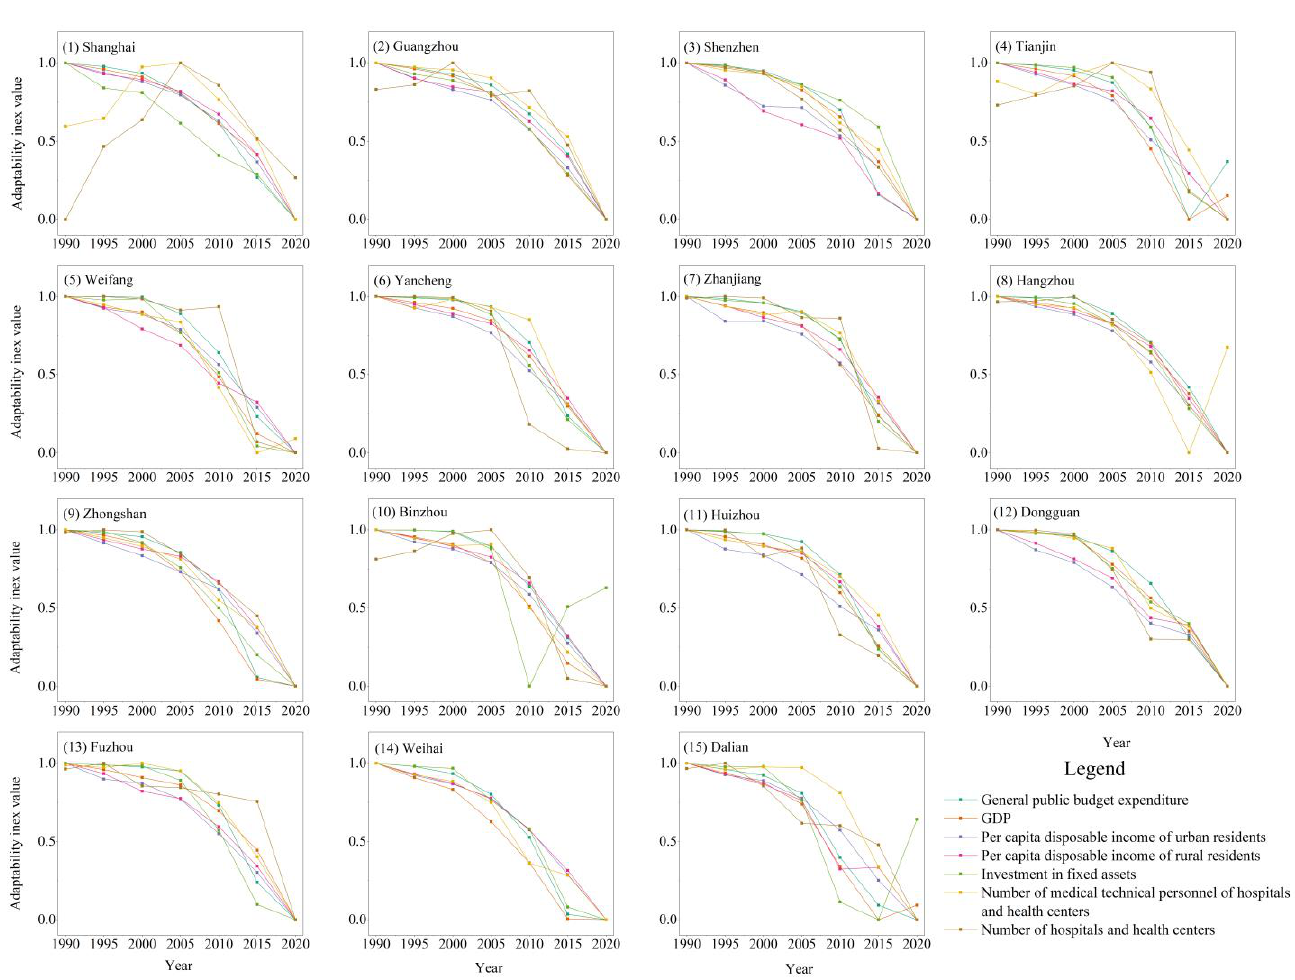
Figure 6. The change trend chart of adaptability index values after negative standardization in 15 coastal cities of China from 1990 to 2020 (the smaller the value, the stronger the adaptability).